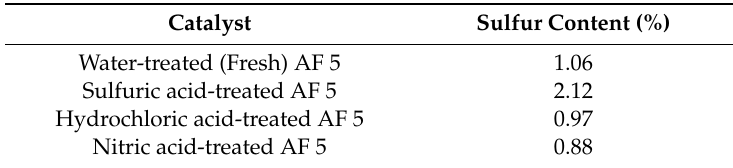
Table 5. Sulfur content in AF 5 samples.